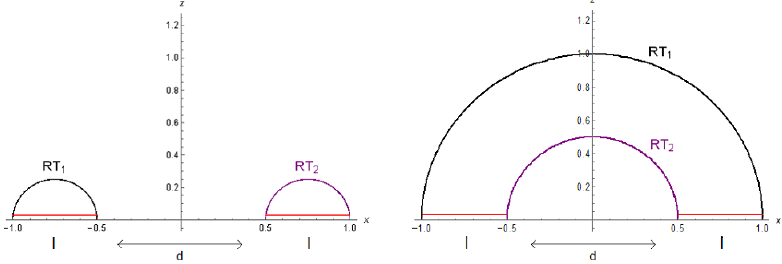
Figure 4 . The possible RT surfaces for disjoint subregions of length l = 0 : 5 with a separation d = 1, on the slice t = 0.